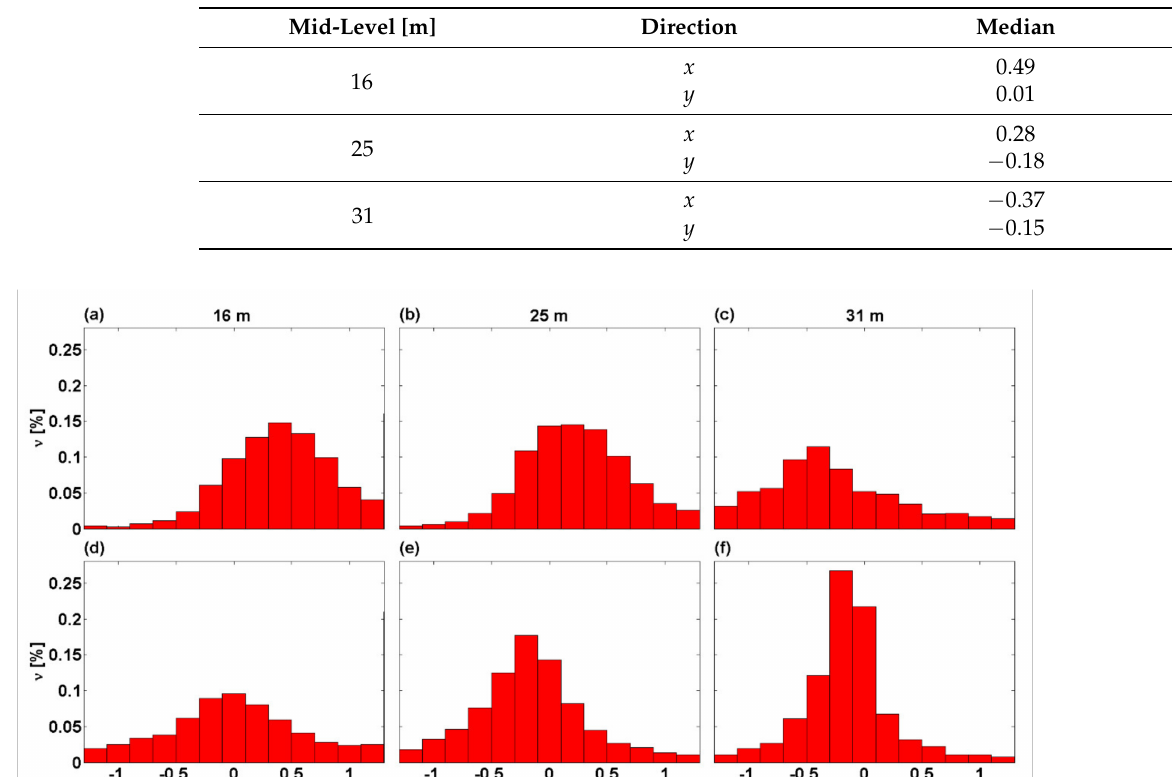
Table 2. Medians of the ratios between the turbulence transport and mechanical production term. Ratios are calculated for all bora episodes and mid − levels.